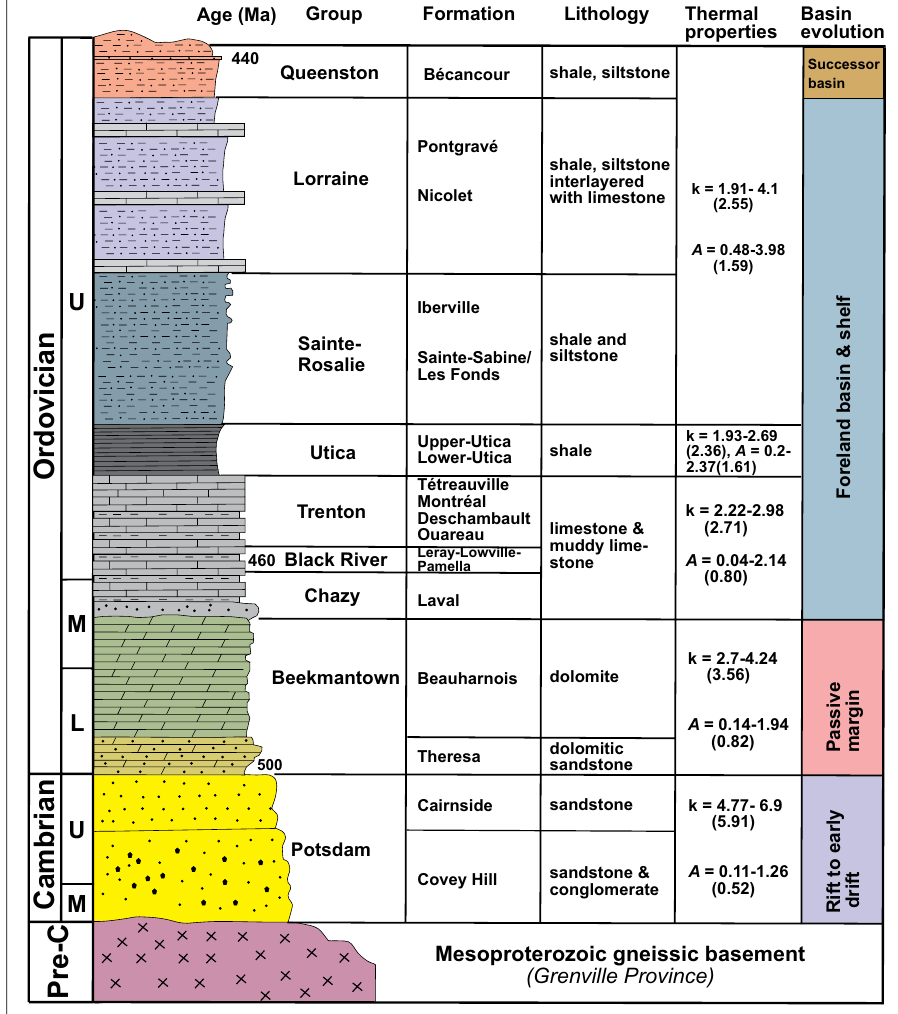
Fig. 2 Stratigraphy of St. Lawrence Lowlands. Stratigraphy of St. Lawrence Lowlands, with lithology, thermal and reservoir properties (thermal conductivity k in W m − 1 K − 1 and radiogenic heat production A in µ W m − 3 , values of the minimum, maximum and mean are in parentheses; Perm permeability). Basin evolution is = modified after (Comeau et al. 2012), combining data obtained from Bédard et al. (2016), Globensky (1987), Hersi et al. (2003), Hofmann (1972), Nasr (2016), Pinti et al. (2011), Rocher and Tremblay